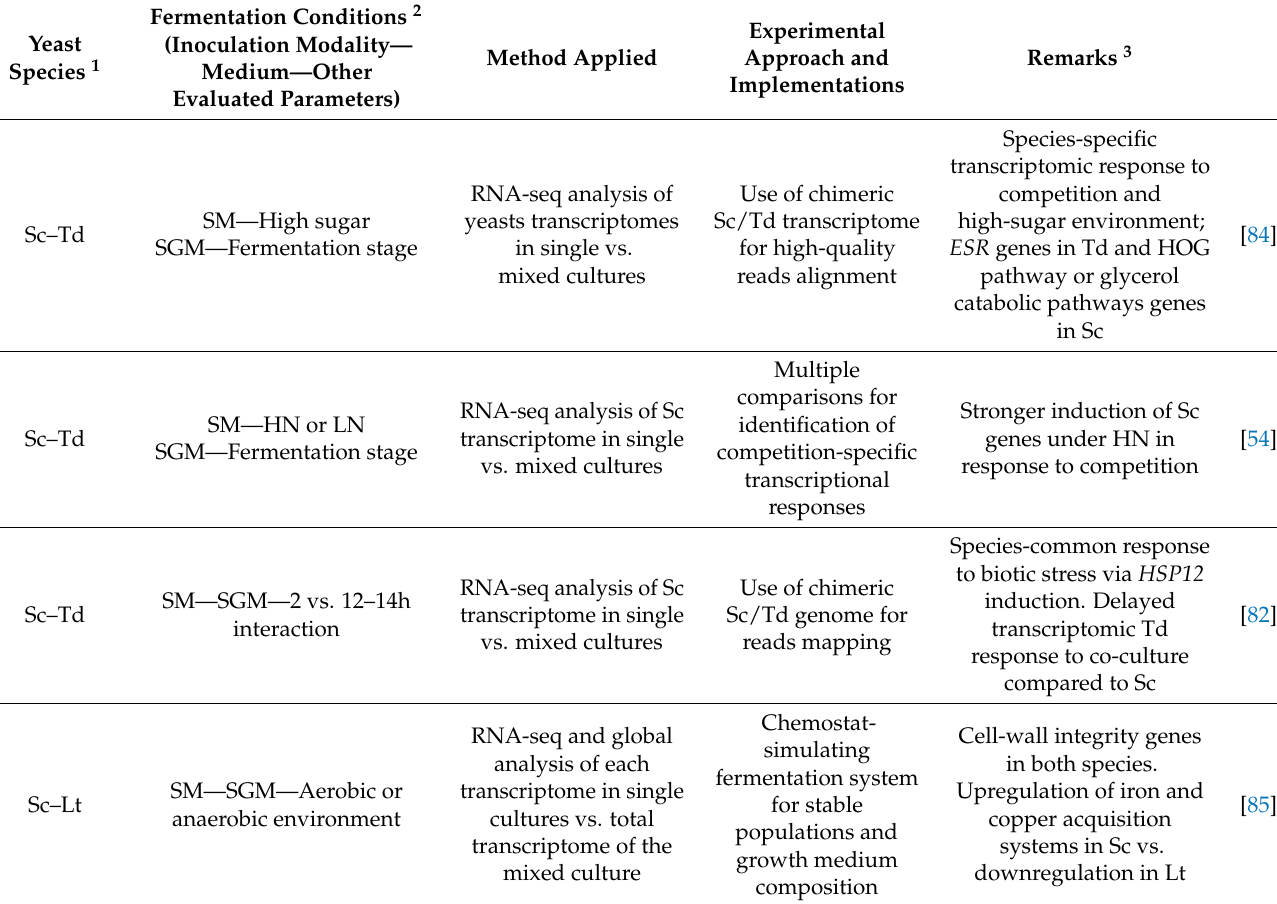
Table 2. Overview of recent studies using gene or protein expression analysis in wine yeast interactions